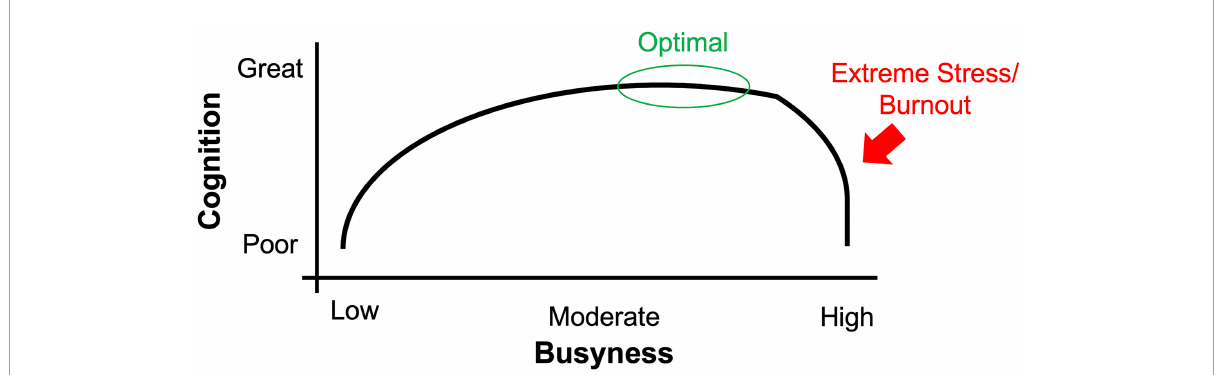
FIGURE1 Hypothesized inverted-U relationship between busyness and cognition. Additional research is needed to test this proposed relationship. Optimal cognitive performance is predicted with moderate-to-high busyness, before extreme stress/burnout is reached.